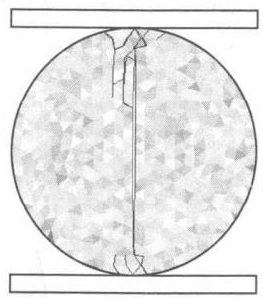
Figure 6. Failure results of specimens in Brazilian splitting physical experiment.